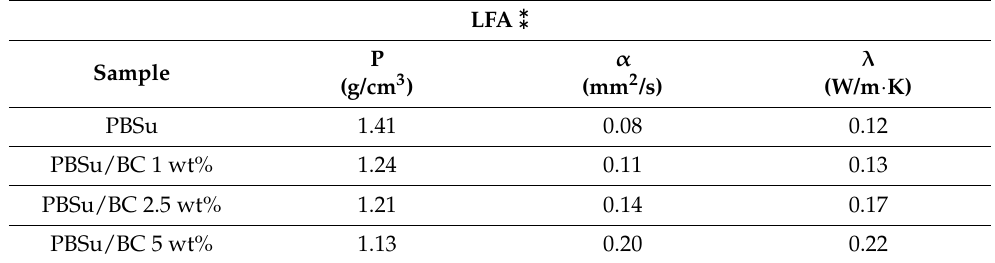
Table 3. Values of interest by LFA.